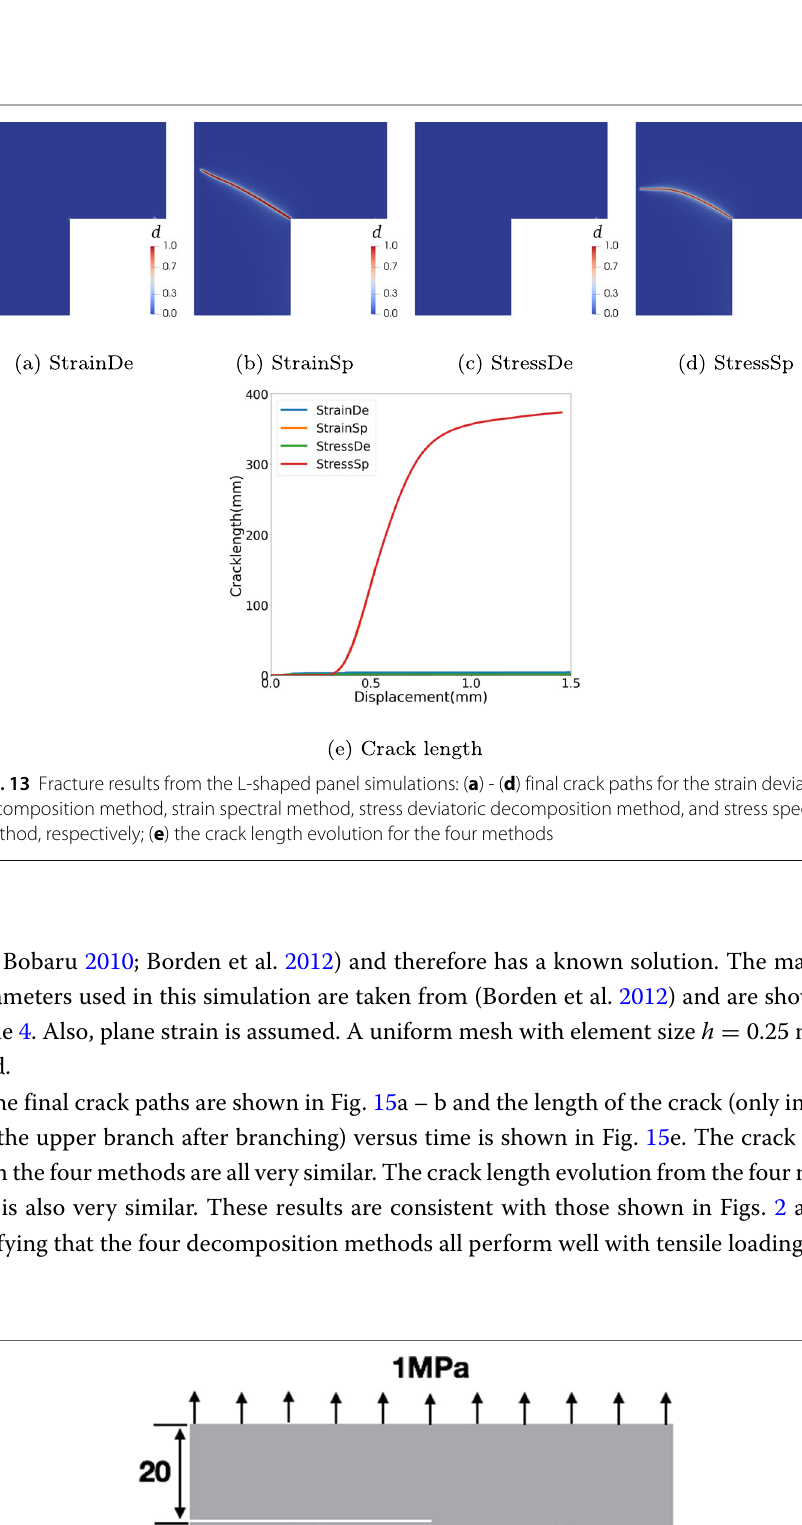
Fig. 14 Geometry, with dimensions in mm, and boundary conditions used in the tensile dynamic fracture